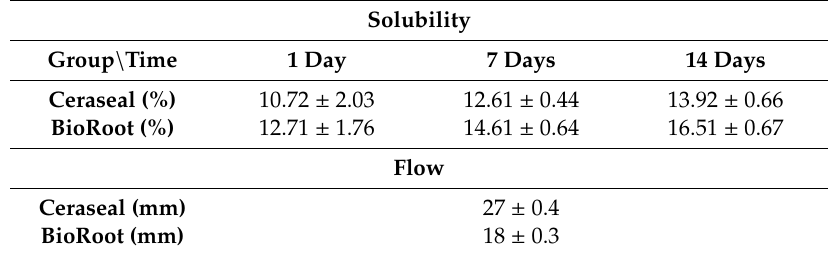
Table 3. Solubility ( n = 5) of Ceraseal and BioRoot in distilled water at 37 °C and flow test ( n = 5). Data expressed as mean percentages with standard deviation.